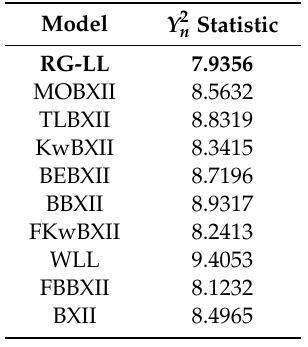
Table 4. Y 2 n statistic to all competitive